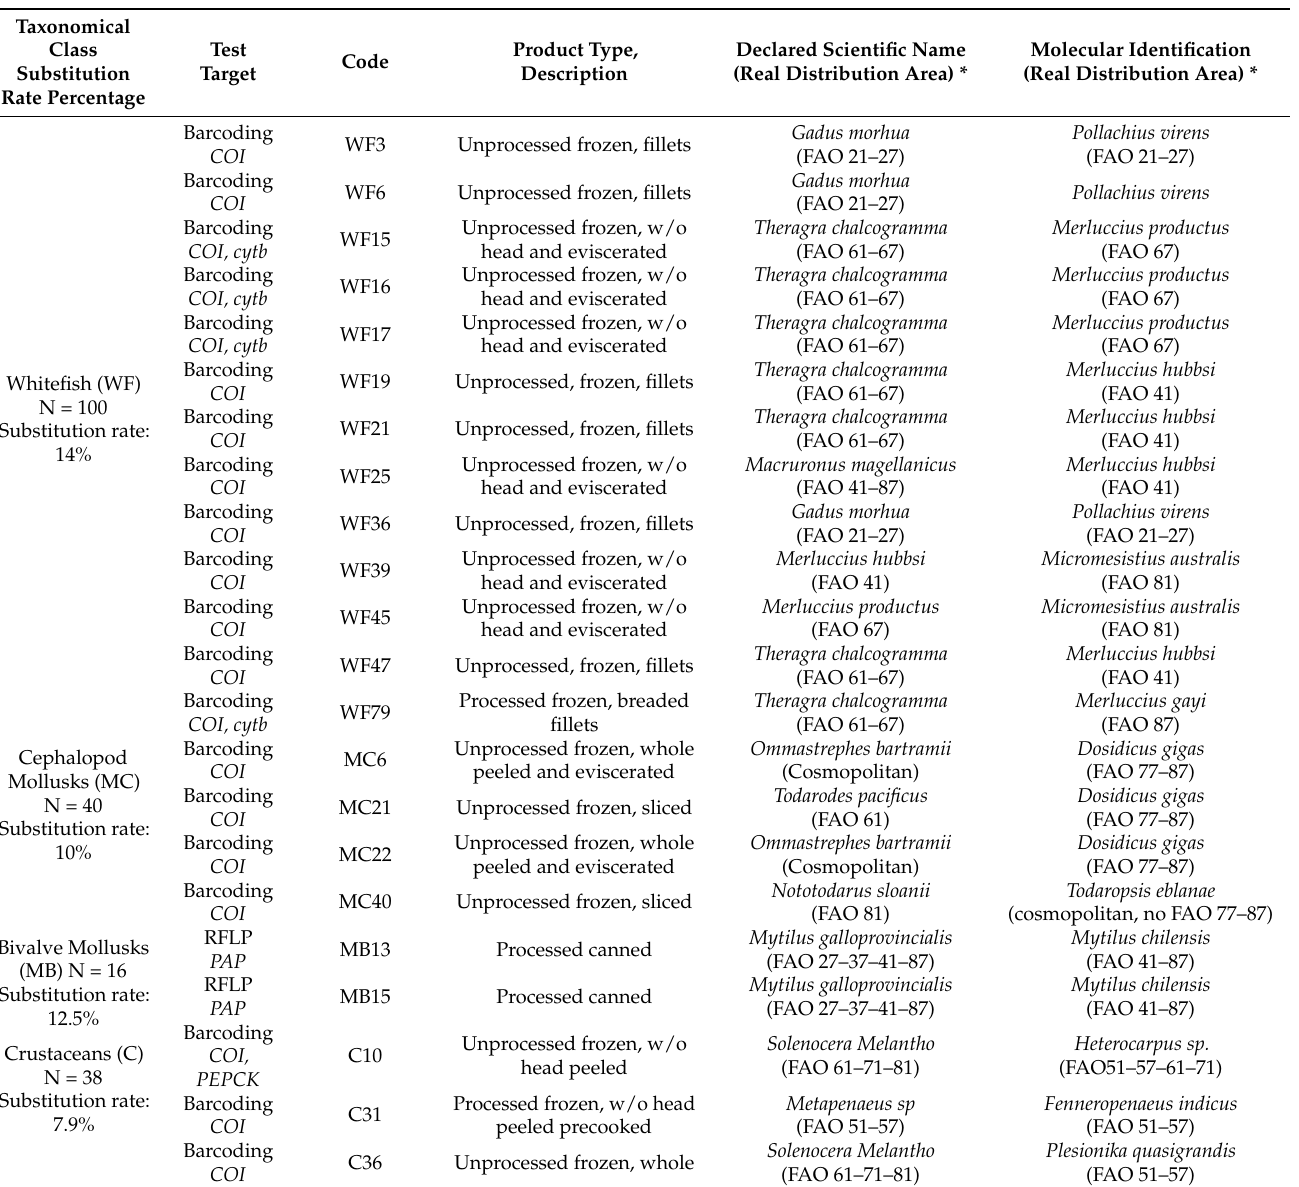
Table 2. List of mislabeled products. * Geographical distribution area verified from FAO databases (Sealife.org and